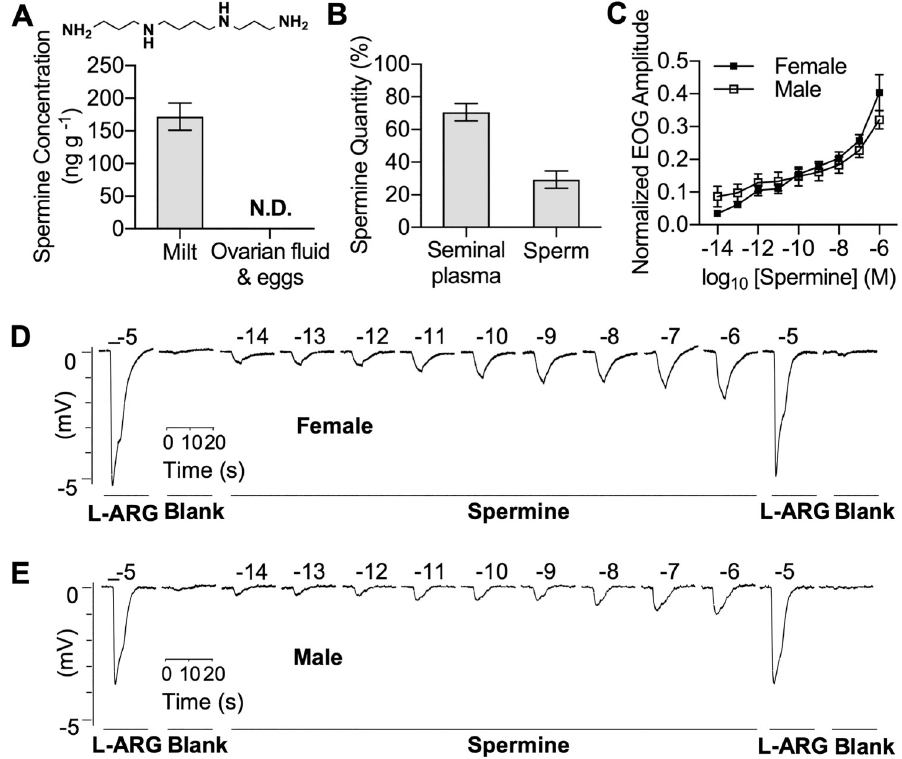
Fig 1. The seminal content and olfactory potency of spermine. (A) The concentration of spermine in sea lamprey milt and ovarian fluid with eggs (mean ± SEM, n = 6), measured with UHPLC–MS/MS. (Inset) Structure of spermine. (B) Percentage of spermine by weight in the milt components, seminal plasma and sperm, determined with UHPLC– MS/MS (mean ± SEM, n = 6). (C) Semi-logarithmic plot of normalized EOG amplitude (mean ± SEM) elicited by spermine (10 − 15 M to 10 − 6 M) in pre-ovulatory female ( n = 10) and pre-spermiating male ( n = 11) sea lampreys. The EOG response to spermine at each concentration was blank-subtracted and normalized to the response of 10 − 5 M L - ARG (standard) for each fish. (D) Representative EOG traces of pre-ovulatory female olfactory epithelia exposed to spermine at concentrations between 10 − 15 and 10 − 6 M. The number above each trace is the logarithmic value of the molar concentration of each stimulant. The bar above the L -ARG trace on the left represents the duration of odorant treatment. (E) EOG traces of pre-spermiating male olfactory epithelia exposed to spermine. Underlying data are available in S1 Data. blank, vehicle solution; EOG, electro-olfactogram; L -ARG, L -arginine; N.D., not detectable; UHPLC–MS/MS, ultrahigh performance liquid chromatography-tandem mass spectrometry.